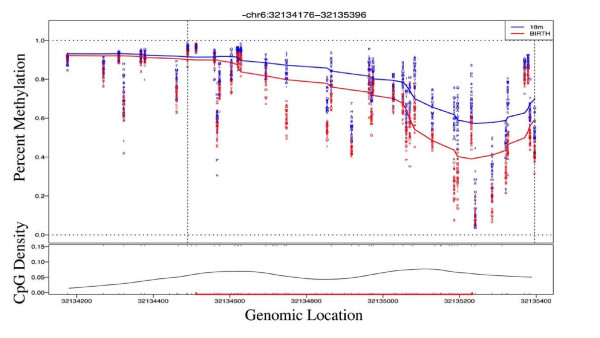
Identification of age-associated differentially methylated regions. Example of a DMR (EGFL8) identified by the peak-finding algorithm. The data show the loess-smoothed β values for all samples at birth (blue) and 18 months (red) according to genomic location. CpG density is shown below and a CpG island represented as a red line.